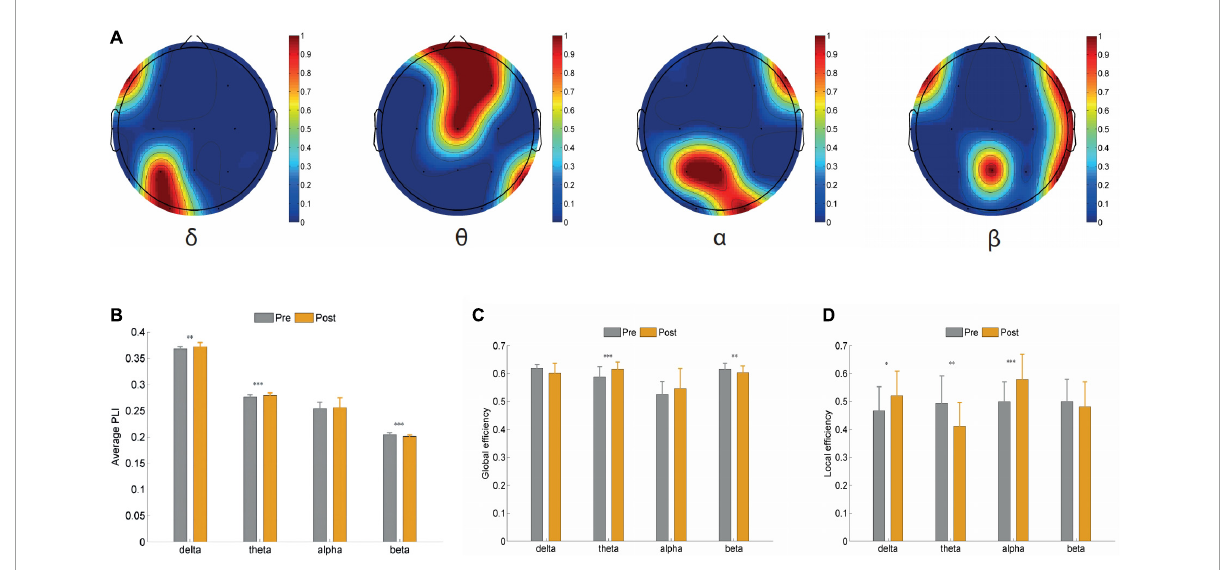
FIGURE8 (A) Global efficiency (GE) local efficiency (LE) of each frequency band was evaluated when the average phase lag index (PLI) sparsity of brain functional connections (B) different frequency bands was equal to 0.3 before and after Qigong group, Delta band, Theta band, Alpha band, and Beta band. (C) The sparsity was set as 30%, GE of each frequency band was evaluated. (D) The sparsity was set as 30%, LE of each frequency band was evaluated. * P < 0.05, have statistical differences. ** P < 0.01, significant statistical differences. *** P < 0.001, significant statistical